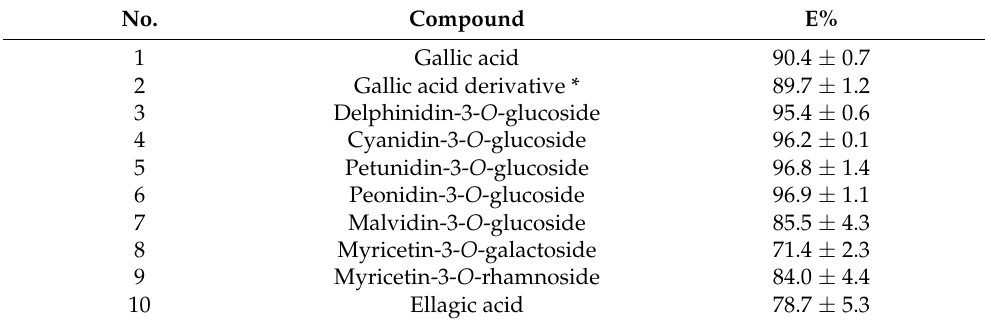
Table 3. Entrapment efficiency (E%) of the main phenolic compounds identified in myrtle extract. No.